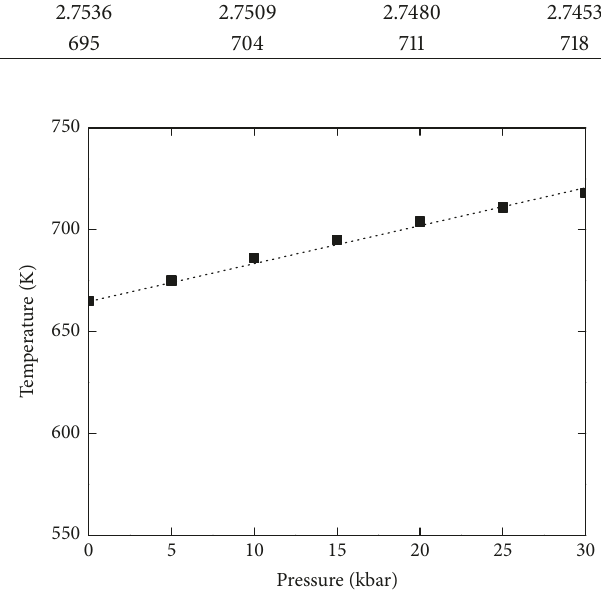
Figure 1: The dependence of the critical temperature 𝑇 𝑐 for alloy Cu 3 Au on